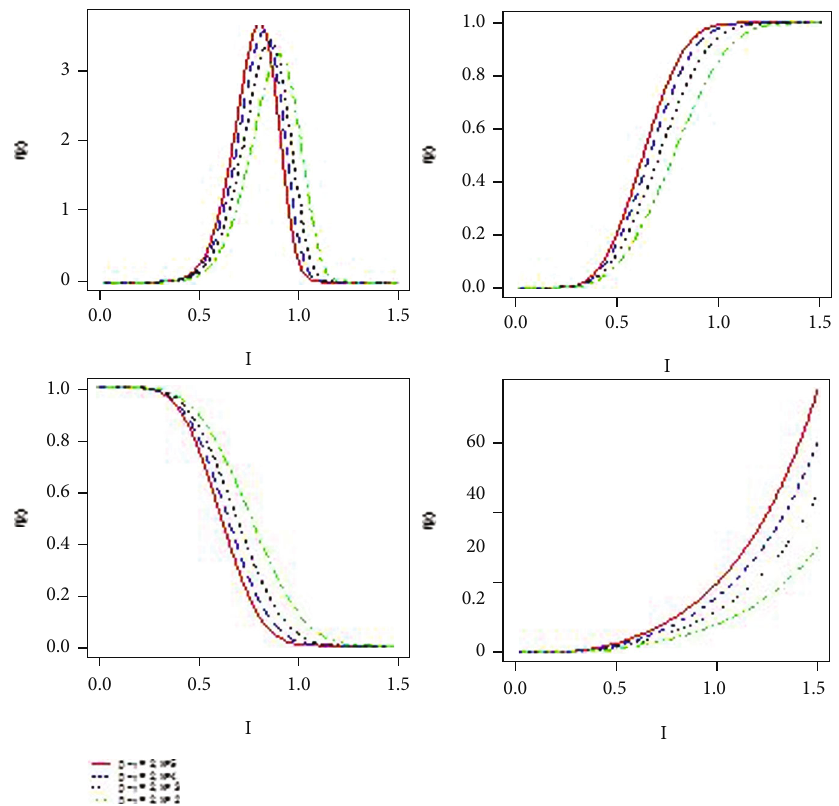
Figure 1: Visual plots for the pdf, cdf, sf, and hf of the proposed